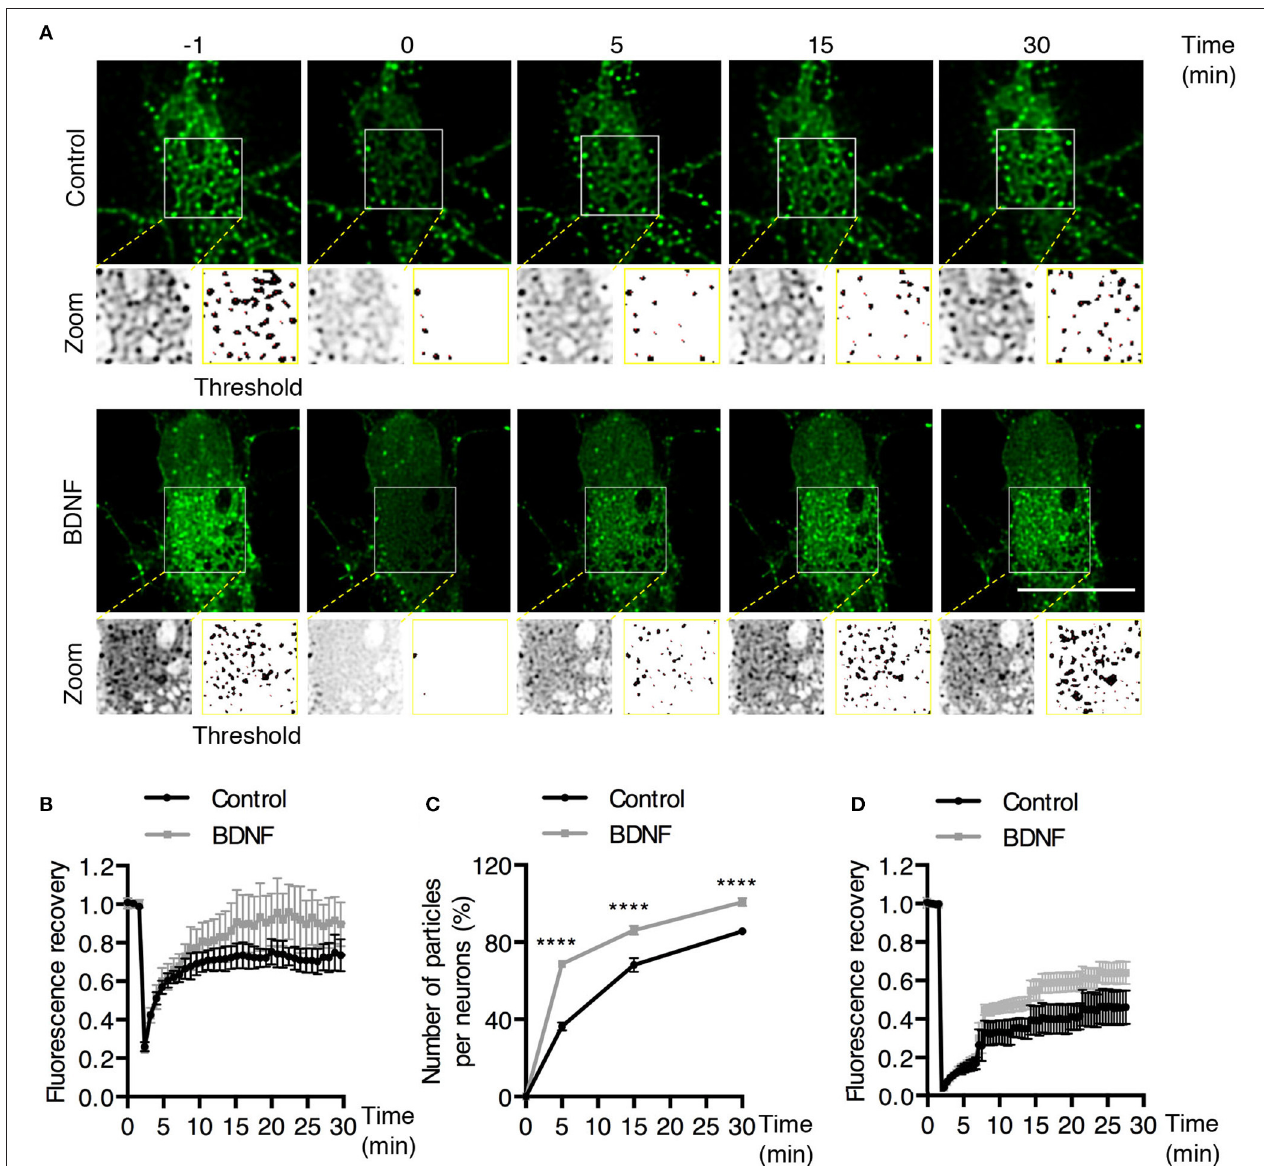
FIGURE 5 | BDNF increases the recovery of Rab5-positive endosomes after photobleaching. (A) FRAP was performed in cell bodies of hippocampal neurons (time 0), and recovery was evaluated after 5, 15, and 30min of photobleaching. Representative individual frame of a recording performed in a neuron expressing EGFP-Rab5. Recording was performed under control conditions or after BDNF treatment. The image shows endosome-like Rab5 particles in the cell body prior to FRAP ( − 1min), during FRAP (0min) and after FRAP (5, 15, 30min). The white square indicated in the picture shows a zoomed-in image. On the right, a threshold image of the zoomed image (left) shows the endosomes quantified in (C) . (B) Time course of fluorescence recovery after FRAP of EGFP-Rab5-associated fluorescence in the photobleached soma. Black squares indicate the control neurons (n = 7) and gray squares the BDNF-stimulated neurons ( n = 7). (C) The graph indicates the percentage (100% fluorescence was established at 1min before FRAP) of endosome-like particles quantified (at t = 0, 5, 15, and 30min) after FRAP. The black squares indicate the values obtained for the control neurons ( n = 7), and gray squares indicate stimulated BDNF neurons ( n = 7). (D) Time course of fluorescence recovery after FRAP of EGFP-Rab11-associated fluorescence in the photobleached soma. Black squares indicate the control neurons ( n = 5) and gray squares the BDNF-stimulated neurons ( n = 6). Four independent experiments were performed. Scale bar, 10 µ m. The results are expressed as the mean ± SEM. **** p < 0.0001 by two-way ANOVA with Bonferroni’s posttest.